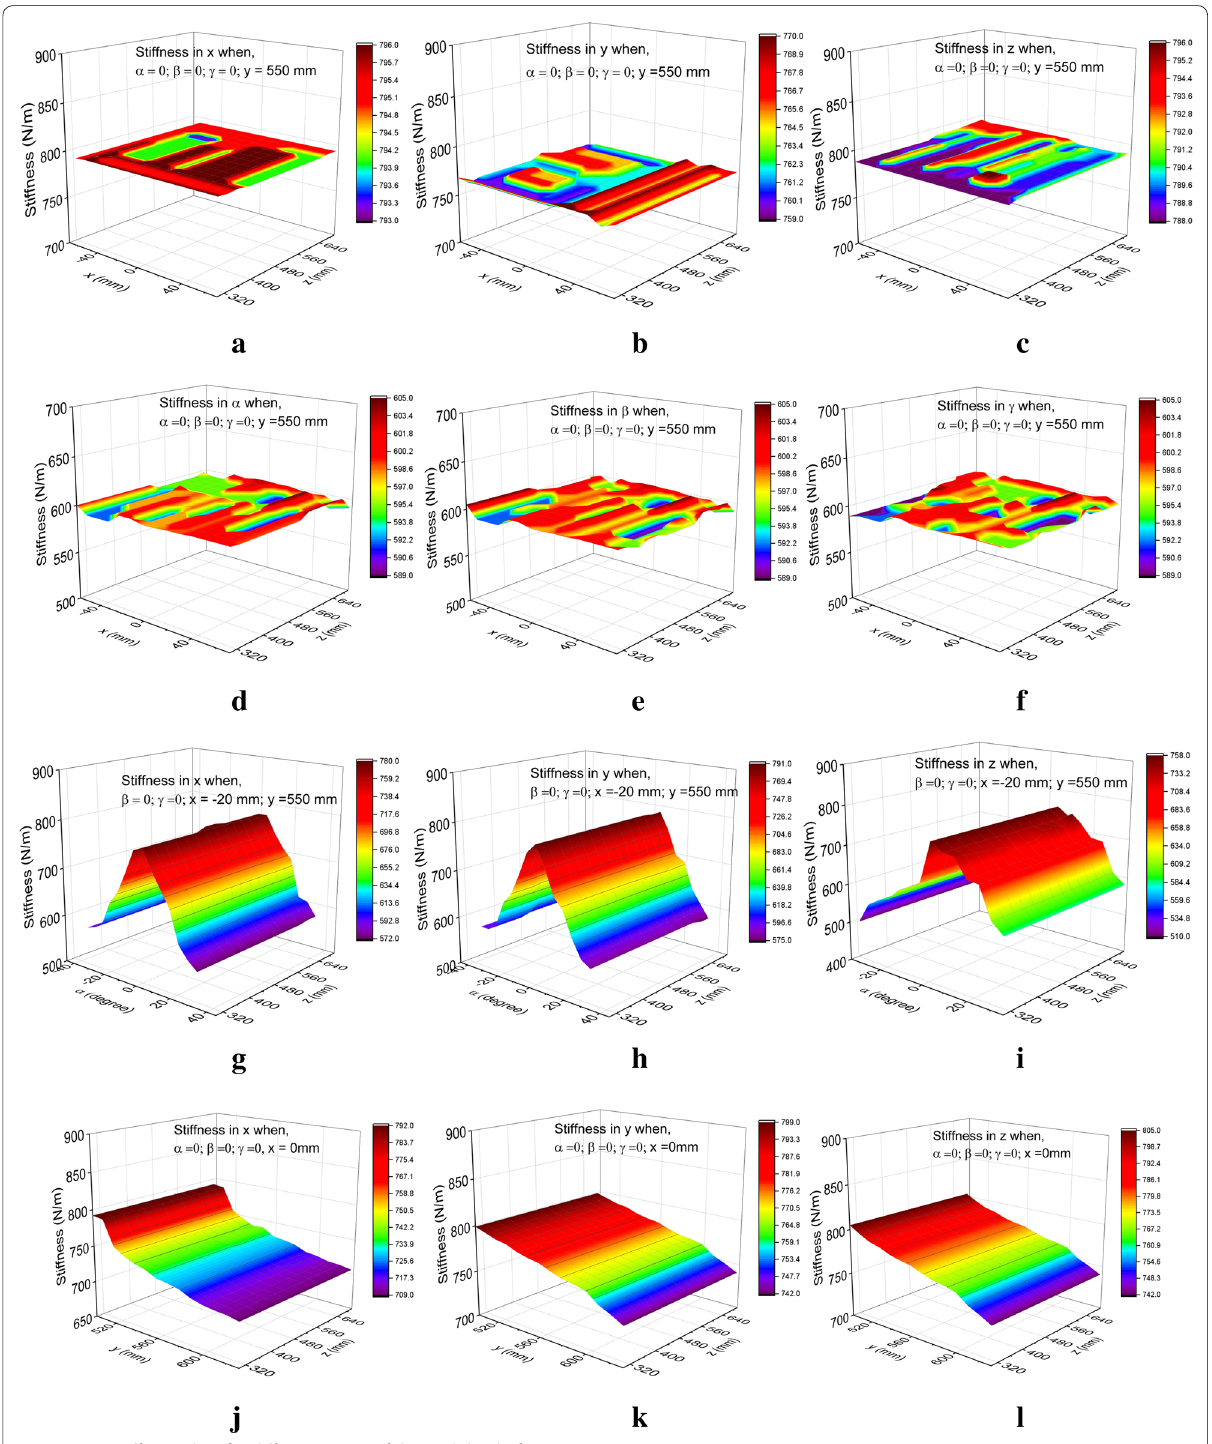
Figure 12 Stiffness plots for different poses of the mobile